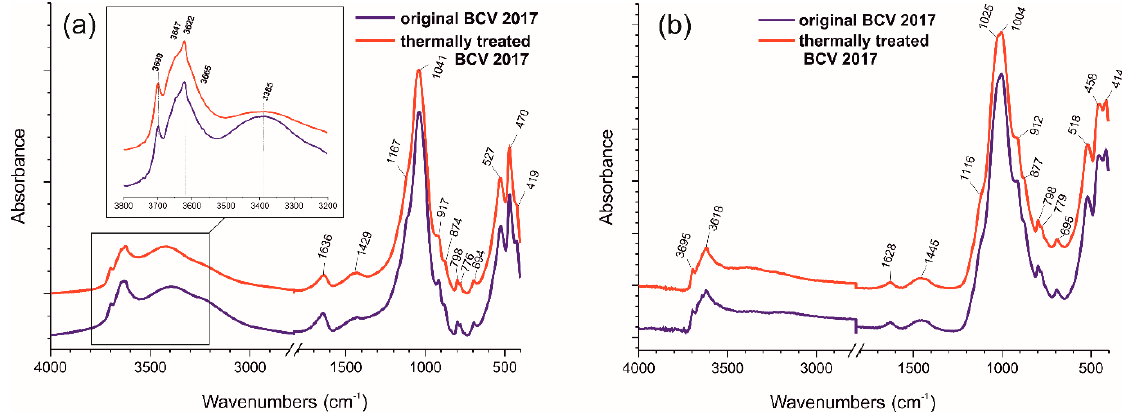
Figure 4. Infrared spectra of the original and the thermally treated BCV 2017 obtained via the ( a ) KBr pellet and ( b ) the ATR techniques. Table 3. Positions of the absorption bands (cm − 1 ) in the IR spectra of the original and the thermally treated (200 °C) samples of BCV 2017 acquired via the by KBr and ATR measuring techniques, and their assignments. Assignment of the Spectral Bands